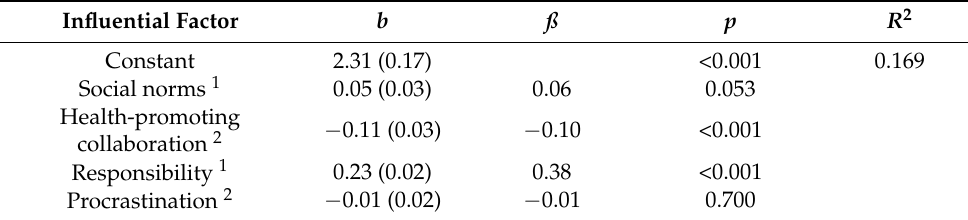
Table 3. Multiple regression of the overall nudge